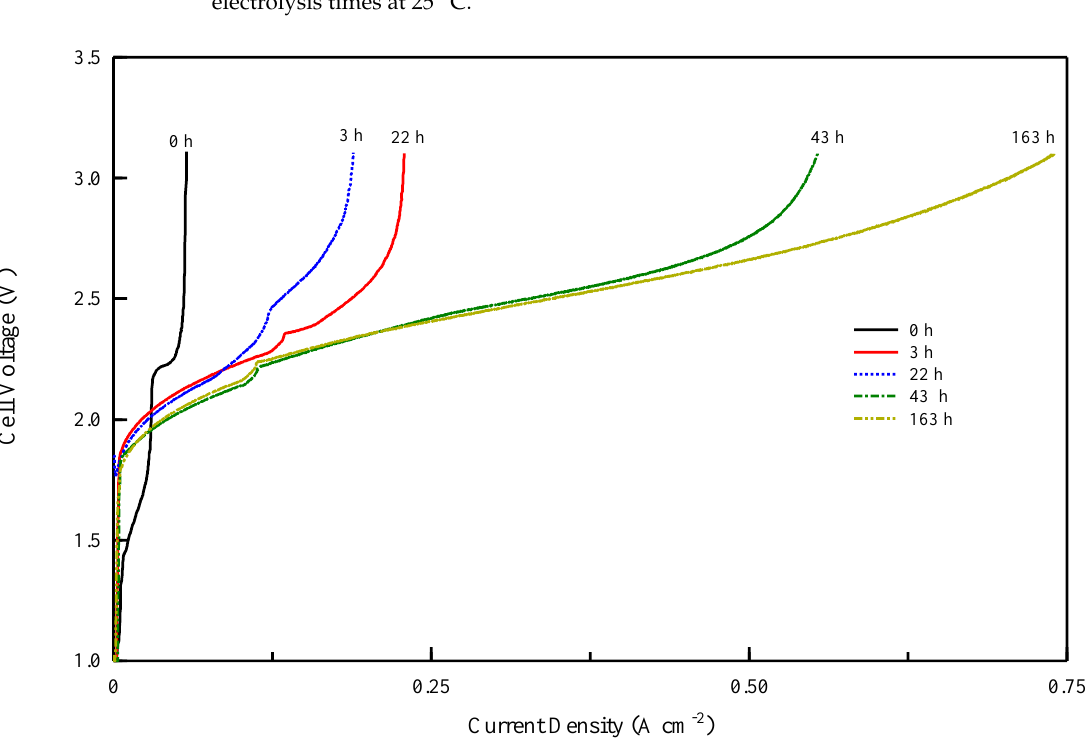
Figure 9. Cell voltage vs. current density profile for Fumasep-PK-130 membrane after different electrolysis times at 25 °C.